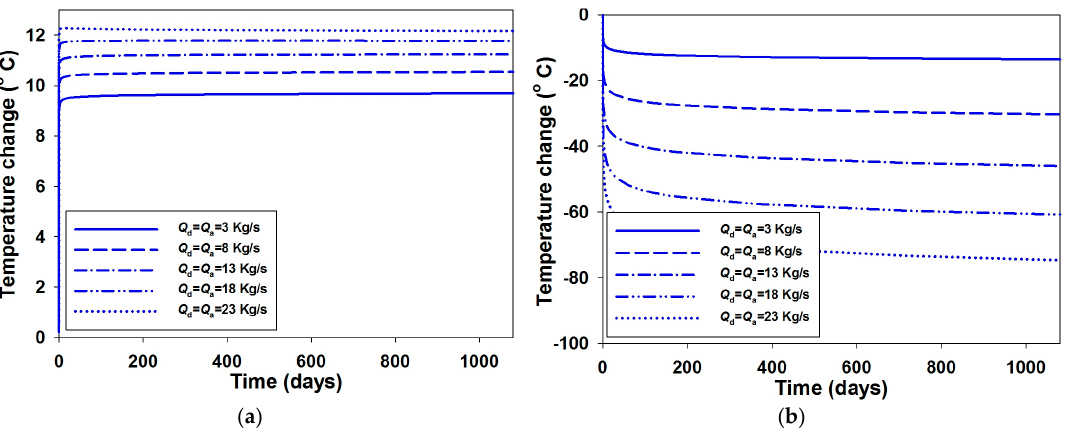
Figure 3. ( a ) Outlet; and ( b ) bottom-hole fluid temperature change under different injection rates.